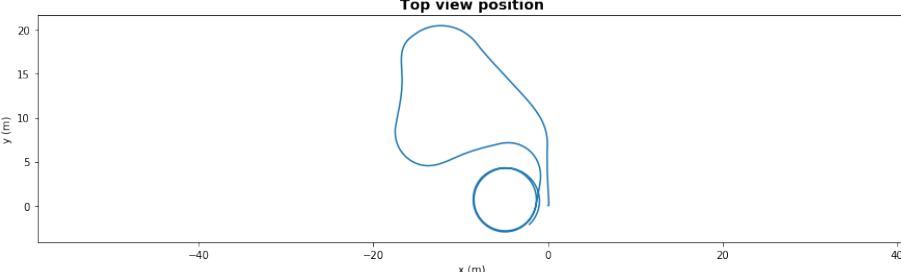
Figure 7. waypoint mission—path with severe degradation and reallocation.